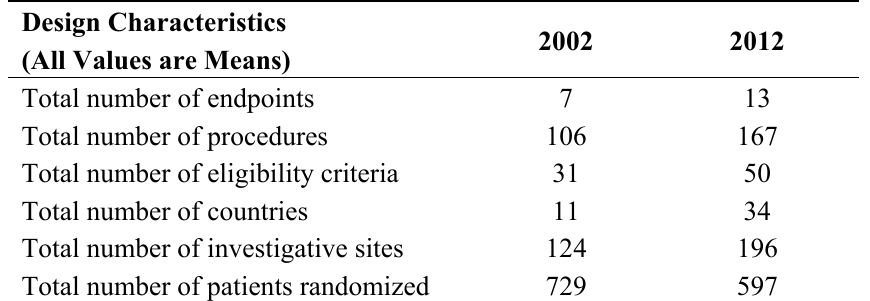
Table 1. Comparing Scientific and Logistical Complexity of a Typical Phase III Protocol Across Two Time